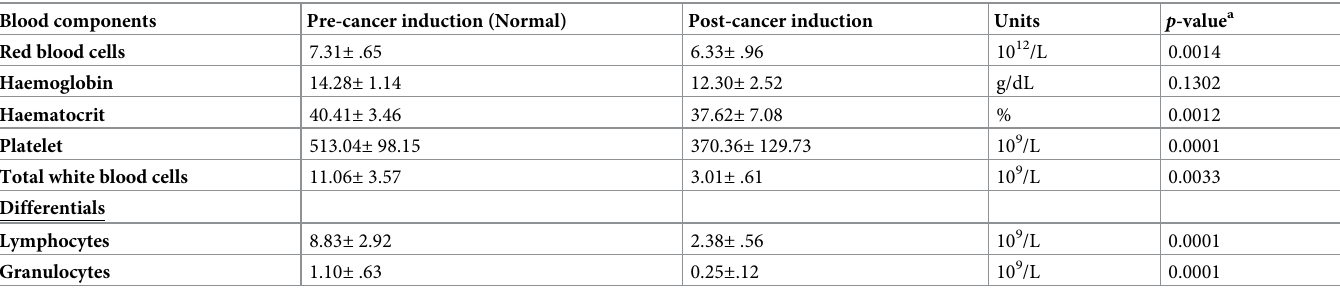
Table 2. Hematologic findings of rat pre and post colorectal cancer